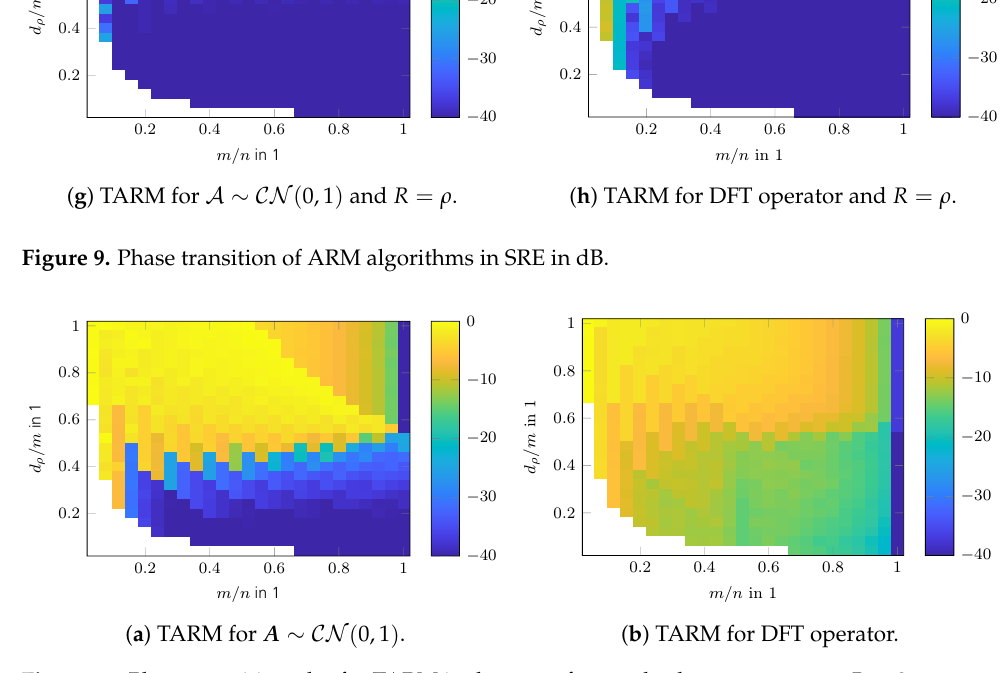
Figure 10. Phase transition plot for TARM in the case of wrongly chosen parameter R = 2 ρ .